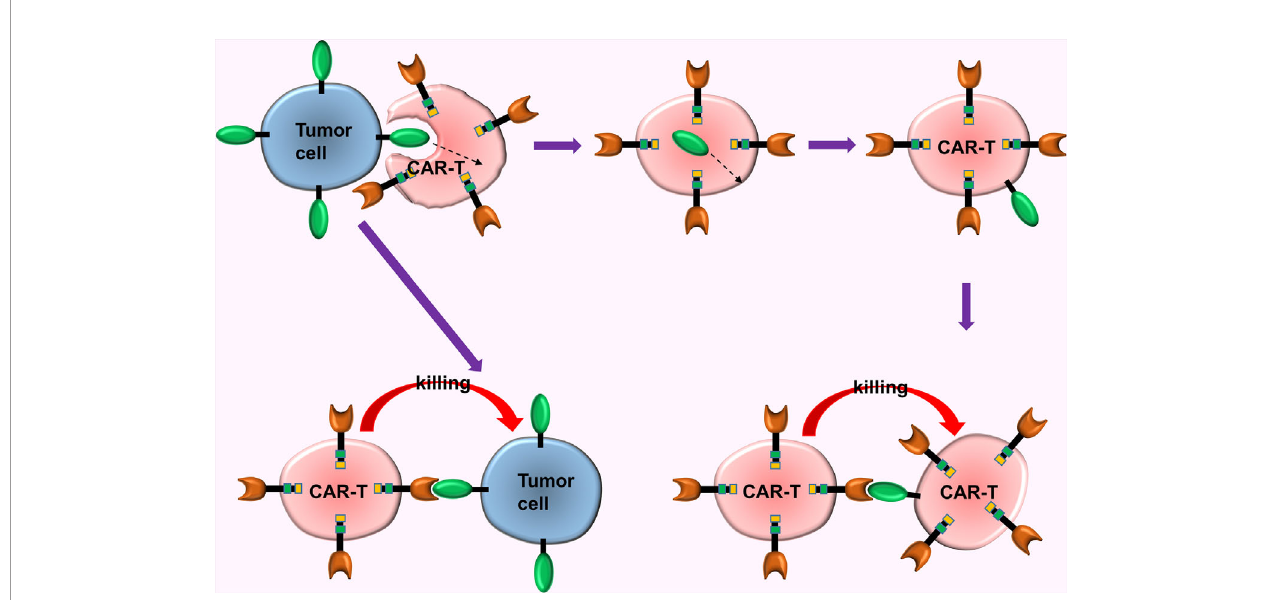
FIGURE 5 | The trogocytosis of CAR-T cells. The CAR-T cells accidentally ingested surface antigens of tumor cells via trogocytosis, and transferred these antigens to the surface of CAR-T cells, causing them to attack each other, ultimately causing the depletion of the CAR-T